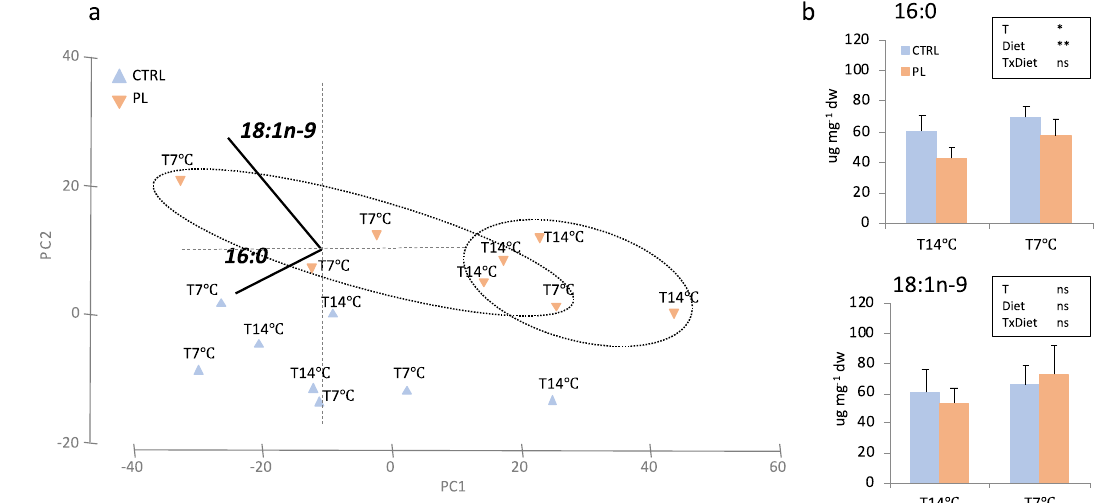
Figure 4. Hepatic FA amounts in animals fed with the control (CTRL, blue) or PL-enriched (PL, orange) diets. ( a ) Principal component analysis (PCA) plot based on FA composition (in µg FA mg dw − 1 ); ( b ) hepatic content of FA significantly correlated with PC1: 16:0 and 18:1n-9; and PC2: 18:1n-9. Data were expressed as mean ± SD ( n = 4). Results of two-way ANOVA are presented in the square (T = temperature; diet = dietary treatment). Asterisk above bars indicates significant differences between temperature treatments (t-test; p < 0.05). * p < 0.05; ** p < 0.01; *** p < 0.001.